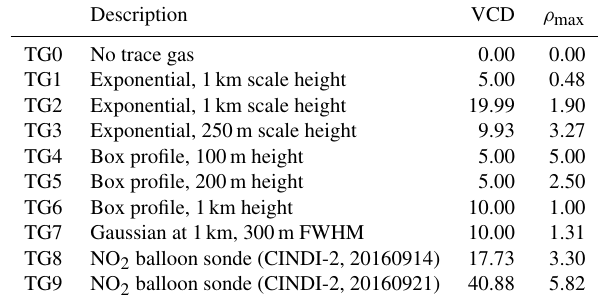
Table 2. Description of the trace gas profiles shown in Fig. 2. The VCD and the maximum number concentration ρ max are given in units of 10 15 moleccm − 2 and 10 11 moleccm − 3 ,